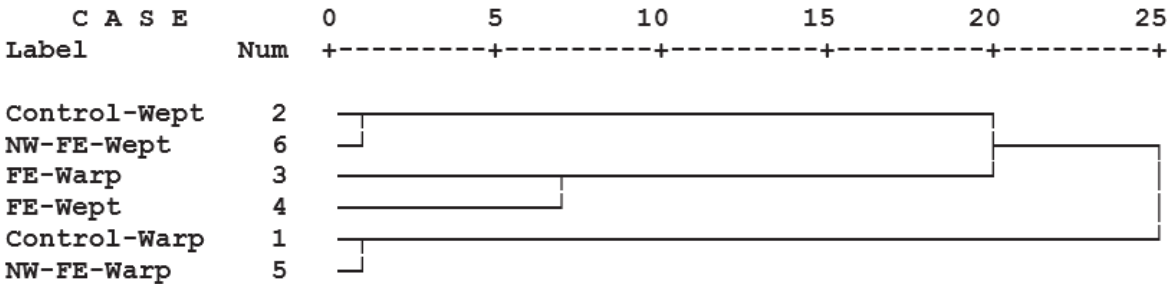
Figure 5 - Cluster analysis of the six treatments of cotton fabric specimens based on tensile strain and tensile stress values before and after exposure to Aspergillus niger fungus for three months (FE = fungal-exposed; NW =